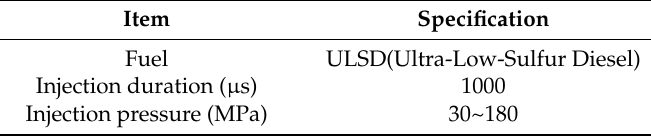
Table 1. Experimental conditions for maximum injection pressure measurement.